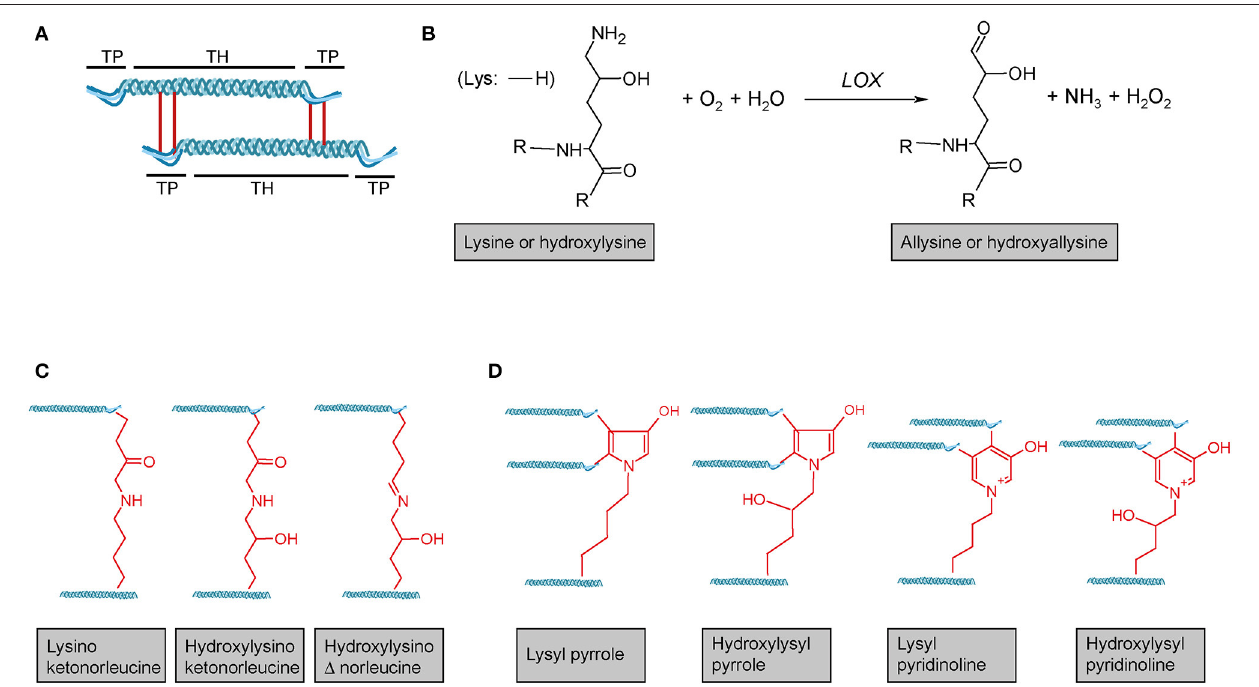
FIGURE 3 | Lysyl oxidase-mediated crosslinking. (A) Schematic representation of telopeptide (TP) and triple-helical (TH) crosslink sites of two adjacent tropocollagen molecules in a collagen fibril. (B) Lysyl oxidase (LOX) enzymes initially catalyse the oxidative deamination of the ε -amino group of a lysine or hydroxylysine, yielding a highly reactive aldehyde group. This entails subsequent reactions with primarily other (hydroxy)lysines and rearrangements, ultimately resulting in different (C) divalent and (D) trivalent collagen crosslinks. R = continued polypeptide chain. Structures were generated using ACD/Chemsketch